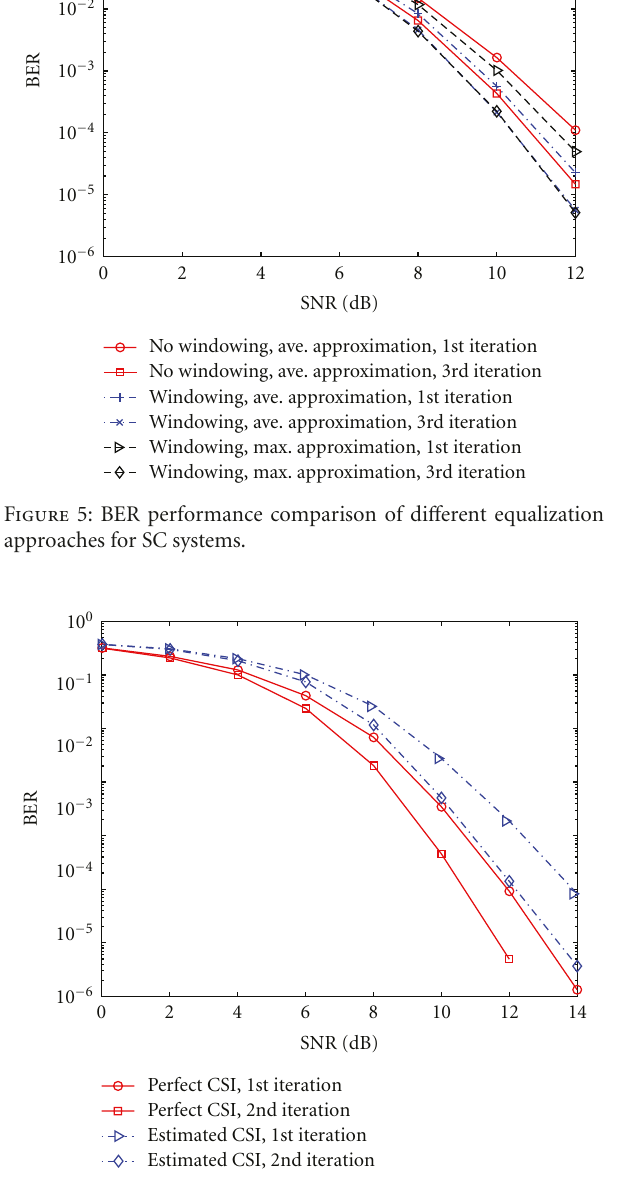
Figure 6: BER performance of SC systems.